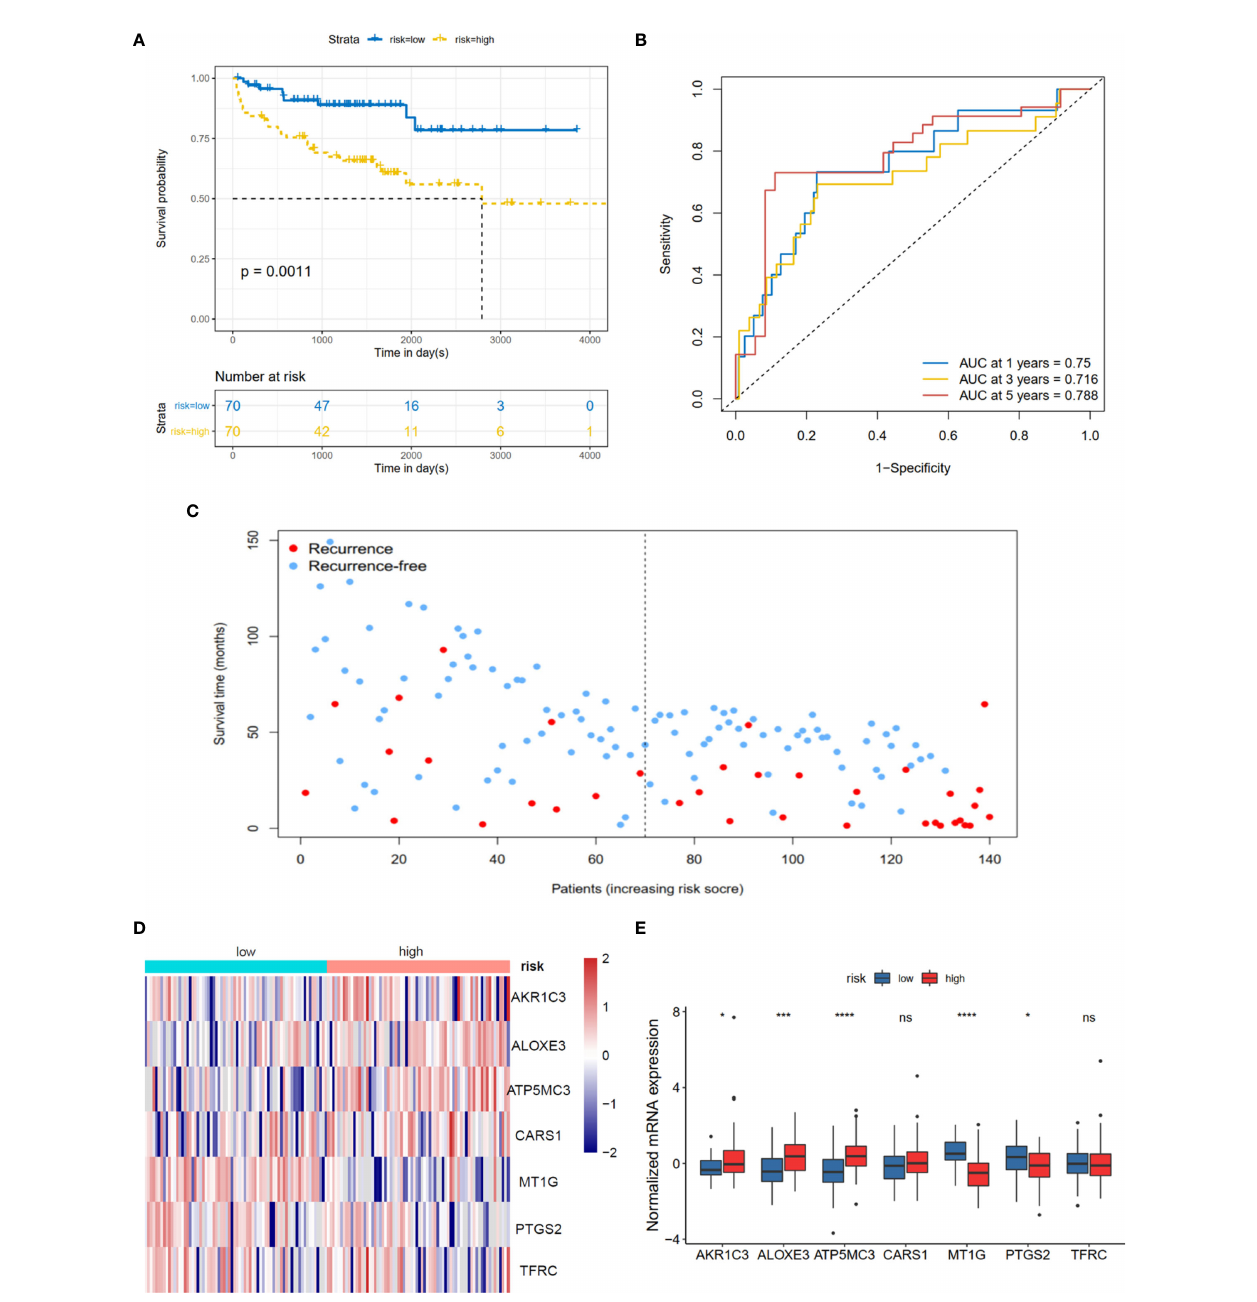
FIGURE 4 | Risk score based on seven hub FRGs in MSKCC PRAD cohort. (A) Survival analysis according to risk score. (B) ROC analysis. (C) Survival status of patients. (D, E) Heatmap and barplot of the seven hub genes between high and low risk group. All the survival analysis are based on the recurrence free survival data. *P < 0.05, ***P < 0.001, ****P < 0.0001. ns, not signi fi